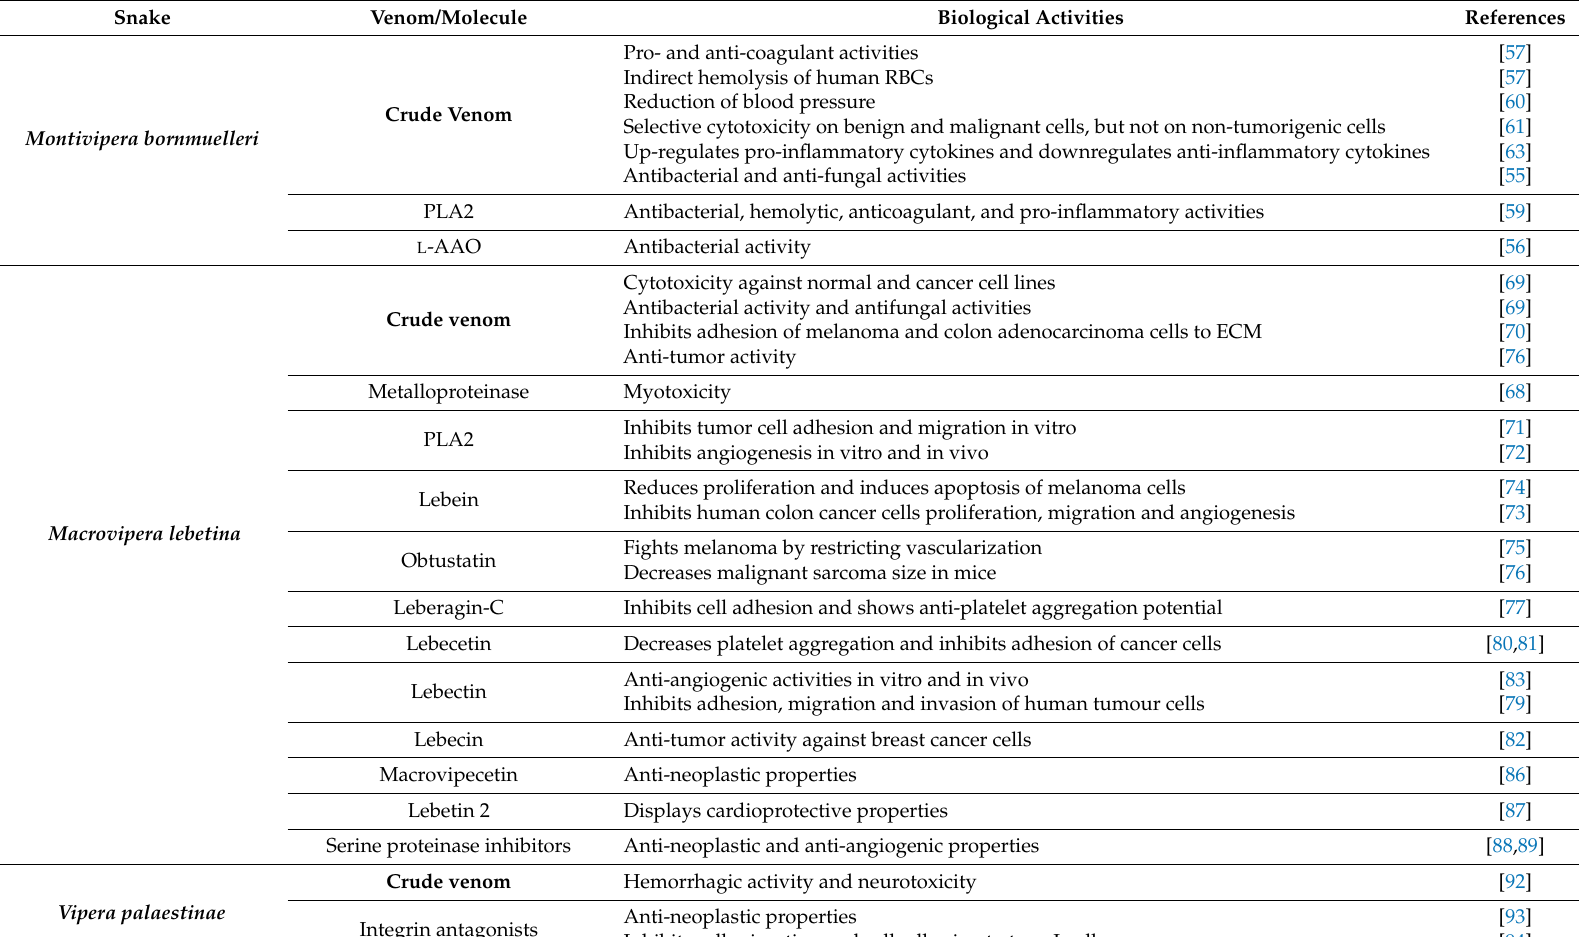
Table 1. Biological activities of Middle Eastern vipers’ venoms and their bioactive